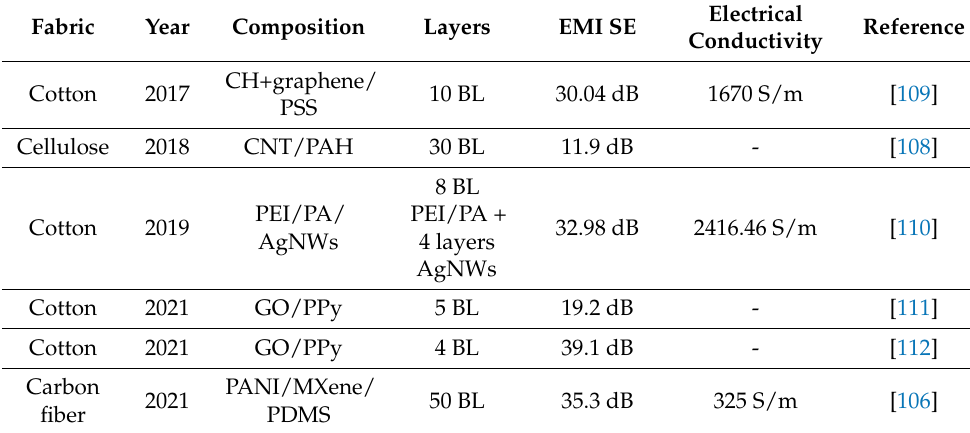
Table 8. EMI shielding LbL self-assembly coating on